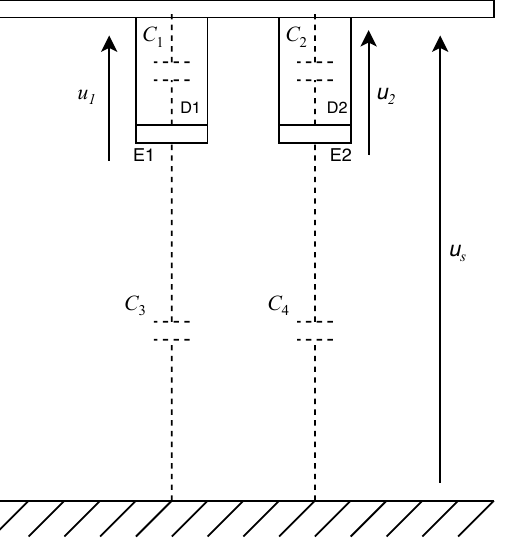
Figure 1. The mechanical construction and electrical diagram of the described sensor. A description of the markings is given in the